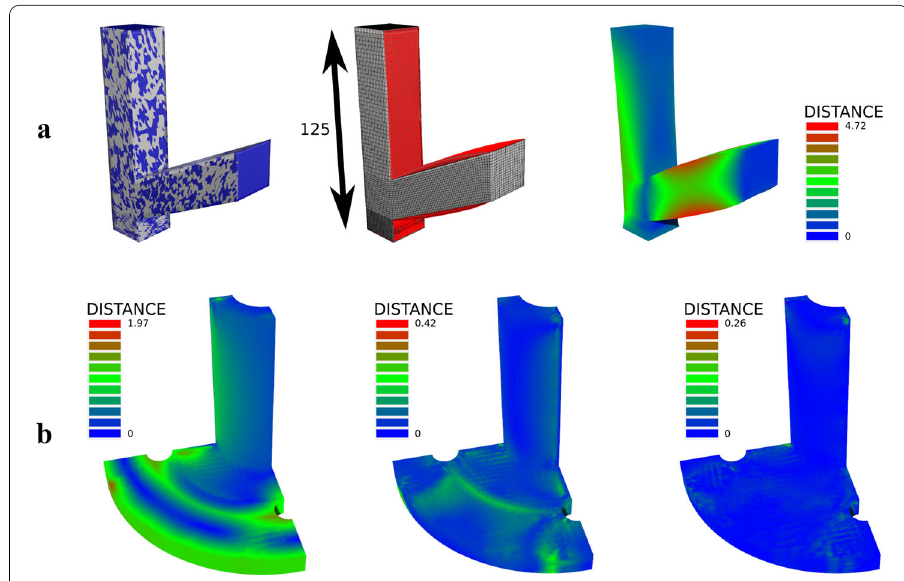
Fig. 22 Accuracy of the MEG-IsoQuad Method and geometric parametric analysis. a B-Rep to reduced order = { X 1 = 40 , model evaluation accuracy analysis on the T-shape part. Used set of parameters is P acc T − shape Y 1 = 40 ,Z 1 = 35 ,X 2 = 40 ,Y 2 = 40 ,Z 2 = 35 ,X 3 = 40 ,Y 3 = 40 ,Z 3 = 35 } . Triangulated mesh (depicted in blue) and generated 3D quadrilateral mesh (depicted in gray), geometric difference is almost zero (left). Geometric comparison between the reduced order model evaluation and a validation snapshot for the same (middle). Distance error analysis of ( a , middle) mapped onto the reduced order set of parameters P acc T − shape evaluation (right). b Reduced order model truncated basis influence on the casting part. Used snapshot has = { L = 80 ,Rb = 120 ,Rh = 35 ,Ri = 20 ,Hb = 15 ,Hh = 140 } . Distance error is analyzed parameters P acc Casting between the reduced order model evaluation and the corresponding snapshot and mapped on the reduced order model evaluation. Error with a basis constructed from the first 5 modes (left). Error using 15 modes (middle). Error using 25 modes